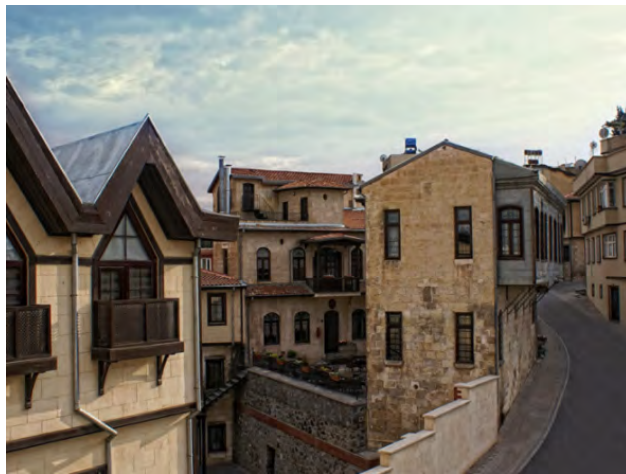
Figure 5. Current condition of Bey neighborhood (Bey Mahallesi, 2018).